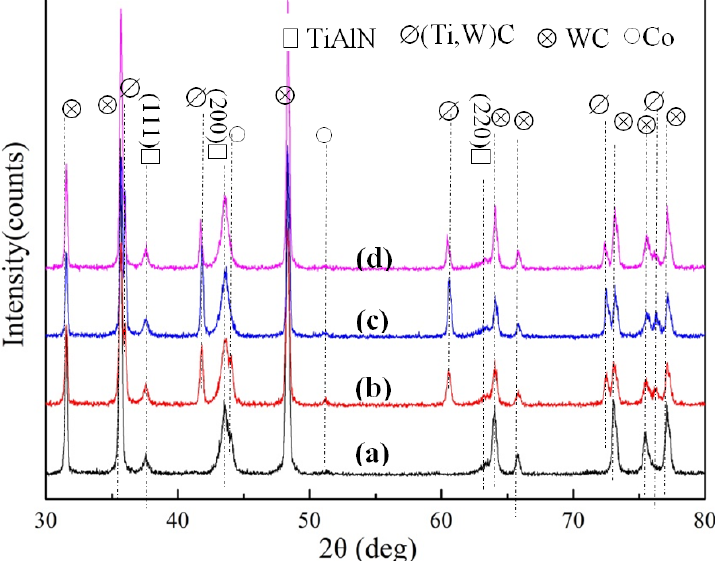
Figure 2. XRD patterns of (a) TiAlN/WT1, (b) TiAlN/WT2, (c) TiAlN/WT3 and (d) TiAlN/WT4 coated cemented carbides.